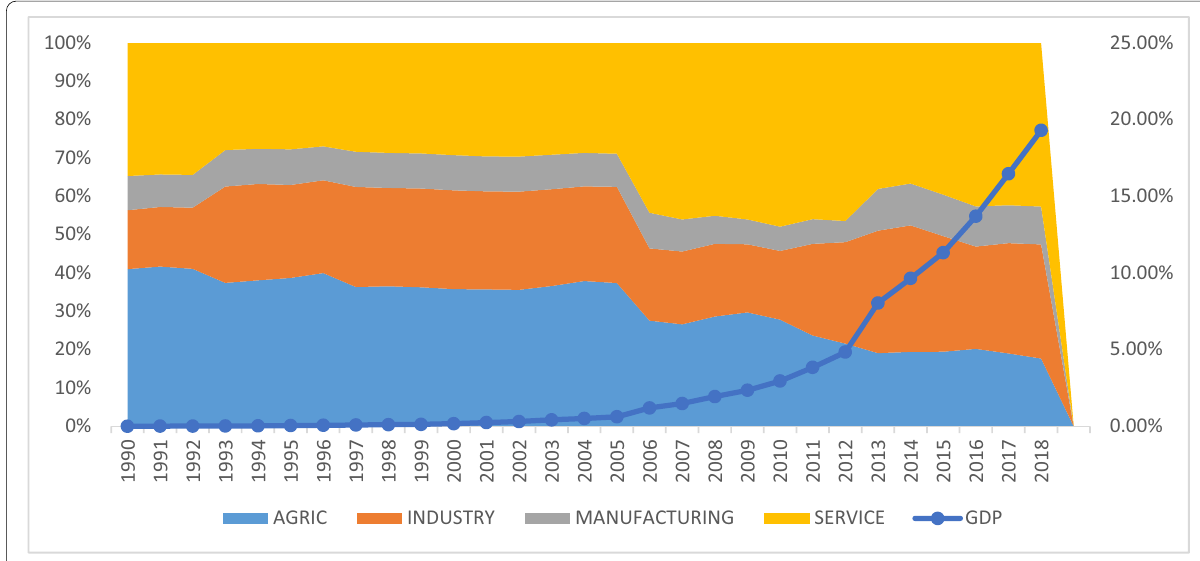
Fig. 2 Trends of economic growth in Ghana. Source: Authors’